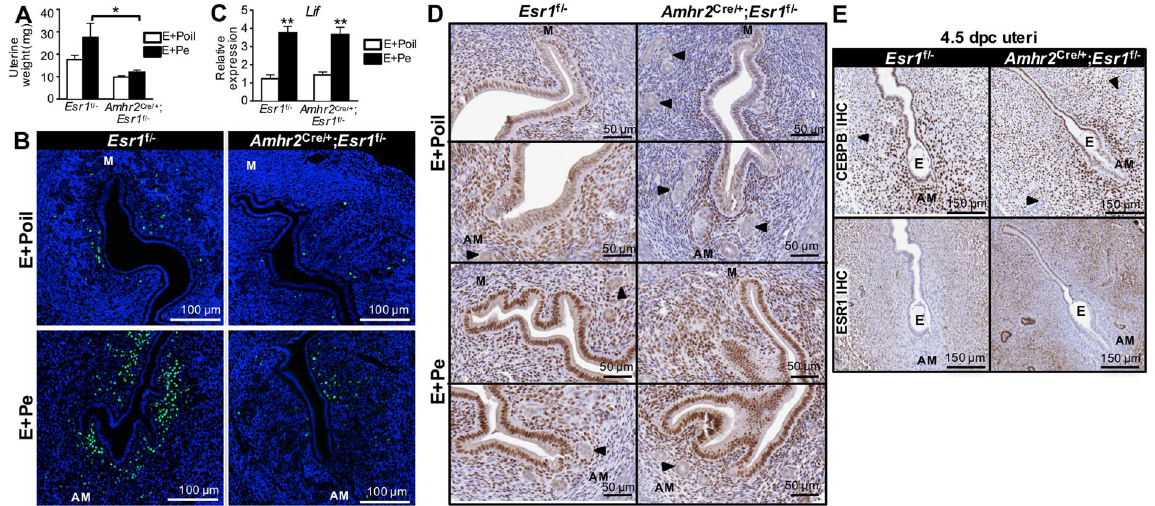
Figure 6. Proliferation of the uterine stromal cells after a series of E 2 and P 4 treatments (E + Pe) to mimic the hormonal profile during implantation and at 4.5 dpc. ( A ) Uterine wet weights of Esr1 f/ − and Amhr2 Cre/ + ; Esr1 f/ − 8–12-week-old females mice treated with E + Poil or E + Pe. * p < 0.05; significant difference between E + Pe treated Esr1 f/ − vs. Amhr2 Cre/ + ; Esr1 f/ − females. ( B ) EdU incorporation assay of Esr1 f/ − and Amhr2 Cre/ + ; Esr1 f/ − female mice that were treated with E + Poil or E + Pe. Cells with green signal represent EdU positive (DNA synthesis) cells. Cells with blue signal represent the nuclei stained with Hoescht. ( C ) Real-time PCR analysis of Lif . Values were normalized to Rpl7 . ** p < 0.01; significant difference between E + Poil and E + Pe treated samples within genotype. All graphs represent mean ± SEM. ( D ) CEBPB IHC staining of Esr1 f/ − and Amhr2 Cre/ + ; Esr1 f/ − female mice treated with E + Poil or E + Pe. Arrowheads indicate glandular epithelial cells. N = 4–6 mice/genotype/treatment. M = Mesometrium, AM = Anti-mesometrium. ( E ) Expression of CEBPB and ESR1 proteins of implantation sites from Esr1 f/ − and Amhr2 Cre/ + ; Esr1 f/ − uterine cross sections at 4.5 dpc using IHC analysis. Representative images shown. N = 3–4 mice/genotype. E =